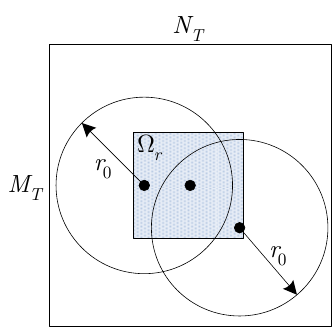
Figure 1. The subtemplate